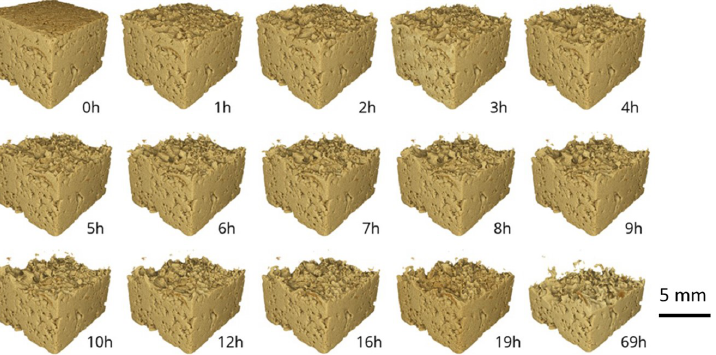
Figure 15. Time-series of micro-CT scans of an epoxy impregnated sample etched with 0.5 M HCl. Only the rock matrix is represented in the 3D images by solid (yellow) to detect the evolution of the acid etching process, while the resin was digitally removed. The scans show that dissolution rate of deeper pats of the impregnated sample was significantly slower compared to the upper